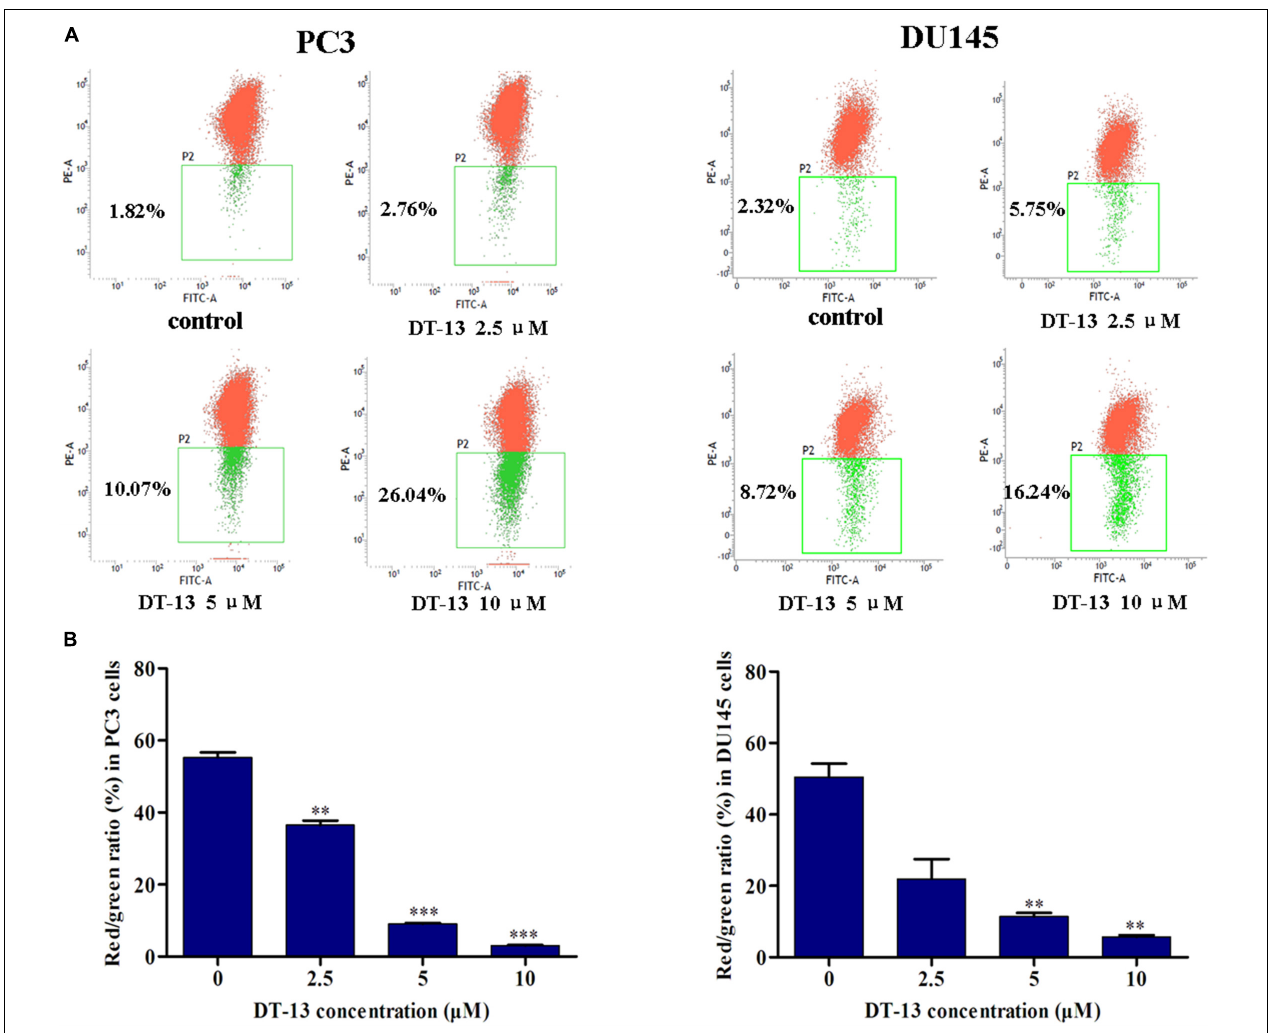
FIGURE 5 | DT-13 reduced mitochondrial membrane potential ( (cid:49) ψ m). (A) Cells were treated with different concentrations of DT-13 for 48 h. The (cid:49) ψ m was evaluated by staining with the potential sensor JC-1 and analyzed with flow cytometry. Representative dot plot (JC-1 aggregated red fluorescence and monomer green fluorescence) out of four is shown. (B) Statistical analysis of the relative ratio of geometric red/green fluorescence. The results represent mean ± SD of three independent experiments, ∗∗ P < 0.01, ∗∗∗ P < 0.001, compared with